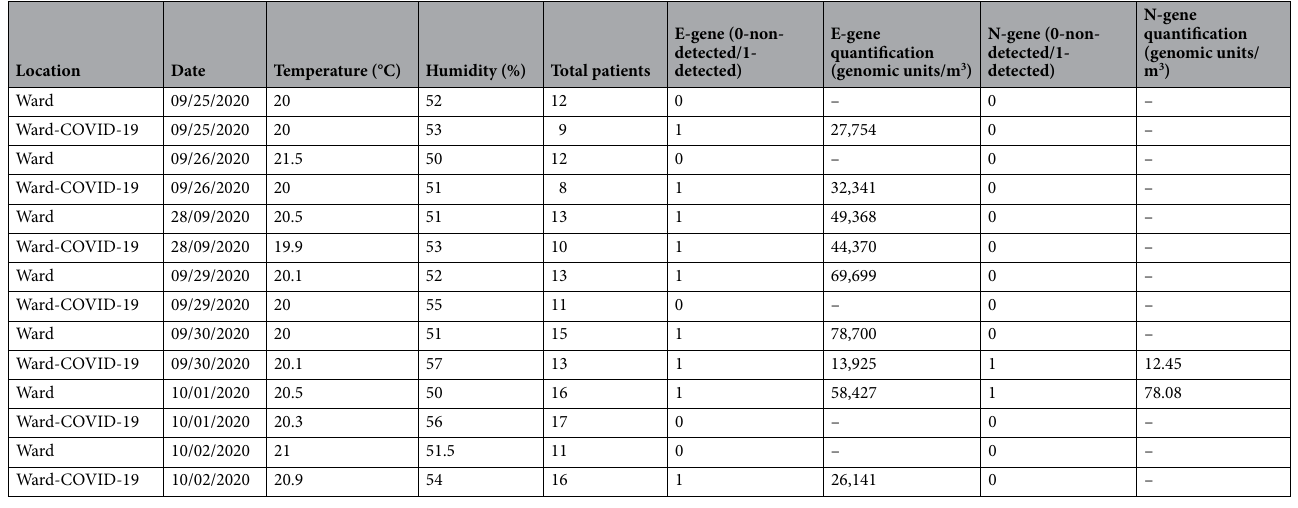
Table 2. Descriptive data of the